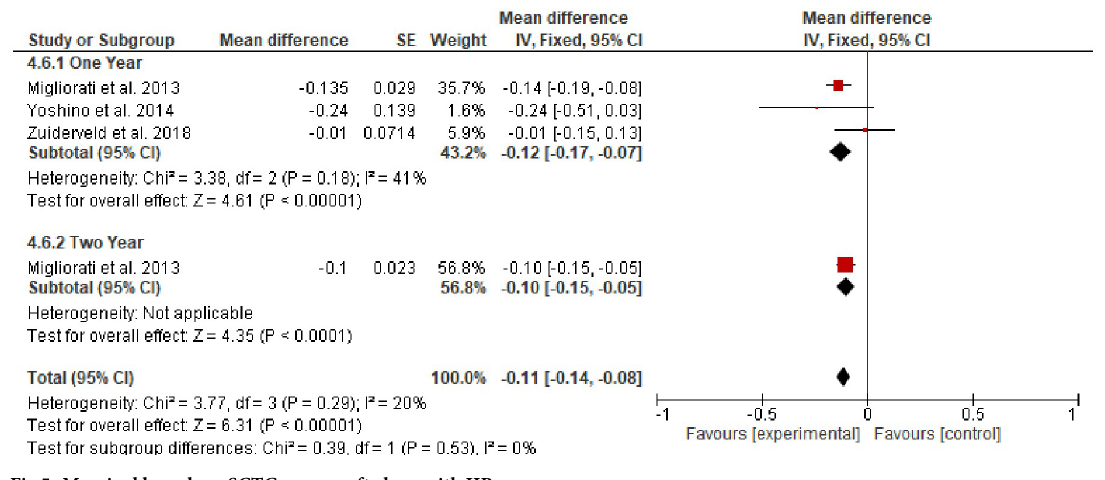
Fig 5. Marginal bone loss, SCTG vs no graft along with IIP.